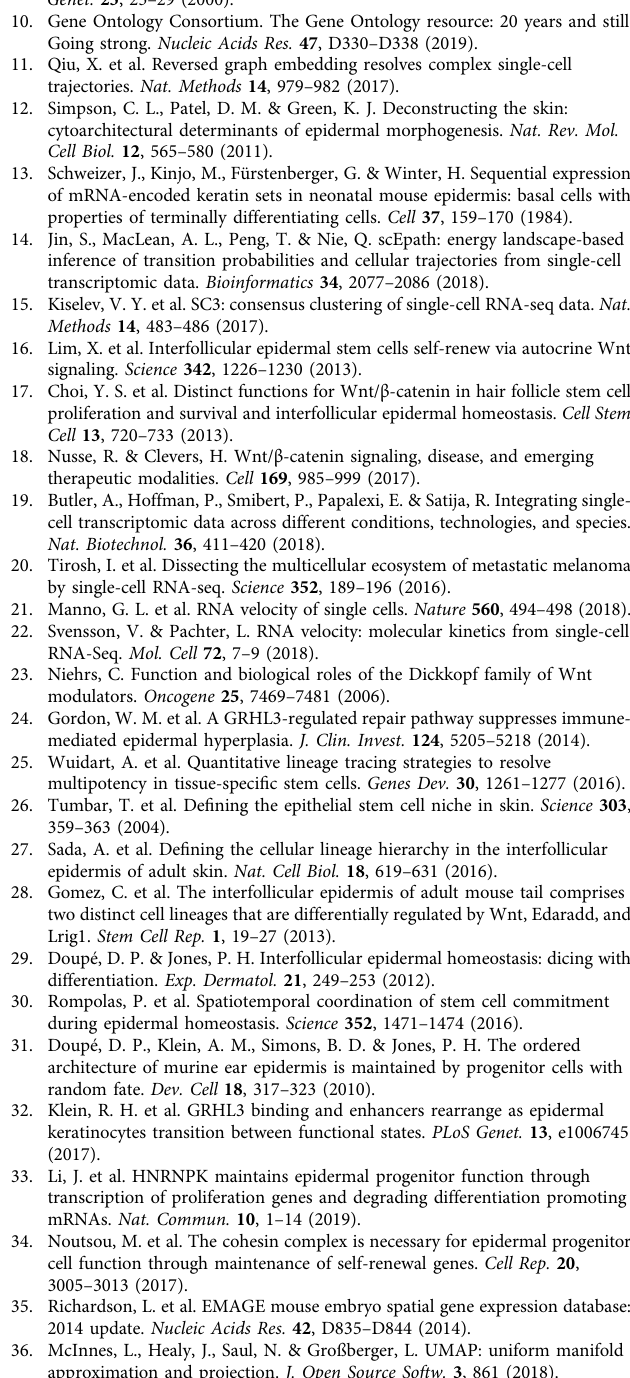
Fig. 7 Wnt inhibition partially rescues epidermal hyperplasia in the Grhl3 − / − IFE. a GRHL3 ChIP-seq signal on the indicated Wnt signaling genes in the E16.5 epidermis. The red bars represent signi fi cant peaks. b Representative RNA-FISH images of Wnt4 (pink) and Lef1 (green) in Grhl3 − / − P0 epidermis treated ex vivo with control (DMSO; left panel) or Wnt inhibitor (Wnt-C59; right panel). There is decreased Wnt4 and Lef1 expression in the epidermis treated with the Wnt inhibitor. Arrowheads point to signal. N = 3 biologically independent samples each. White broken line traces basal lamina. E epidermis, D dermis, HF hair follicle. c Representative sections of Grhl3 − / − P0 epidermis treated ex vivo with control (DMSO; left panel) or Wnt inhibitor (Wnt-C59; right panel), representative image for N = 3 each. Krt14 staining, red; Krt10 staining, green; DAPI staining; blue; HF, hair follicle. There is decreased IFE thickening of the Wnt inhibitor treated epidermis. Scale bar = 10 µ m. d Summary statistics for IFE thickness, mean and standard error